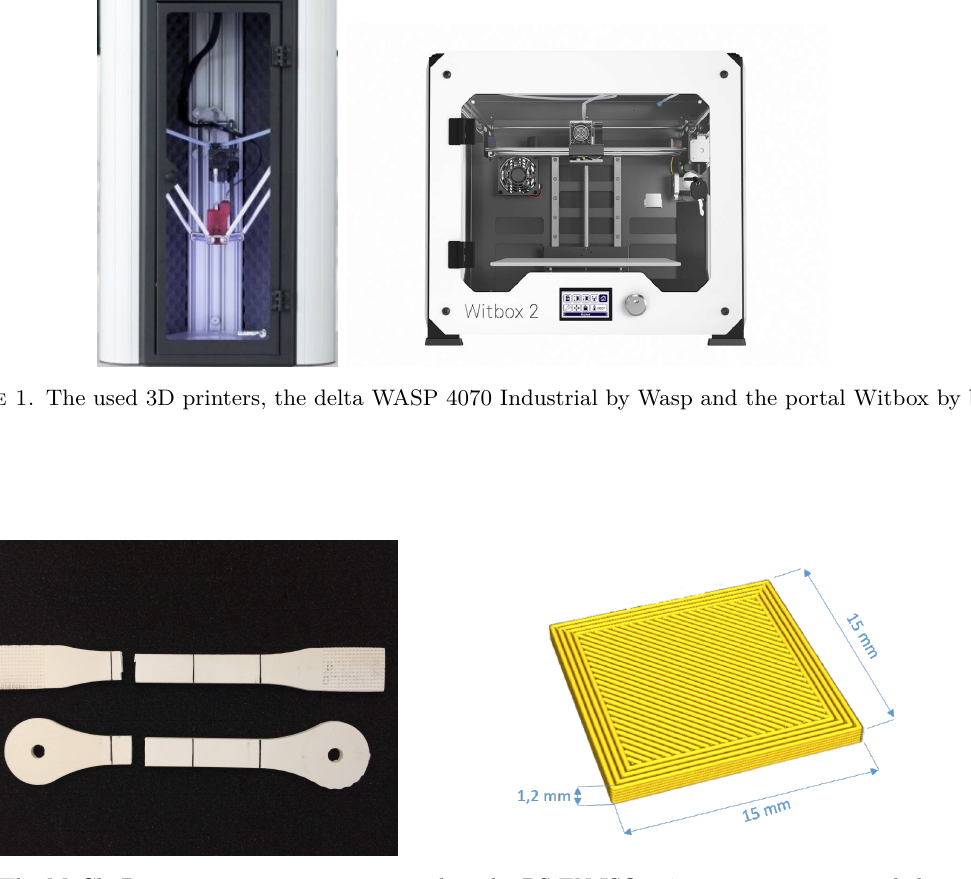
Figure 2. The MaCh3D specimen specimen compared to the BS EN ISO 527-2:2012 specimen and the prismatic specimen used for wettability and morphology characterizations bonding method for highest mechanical